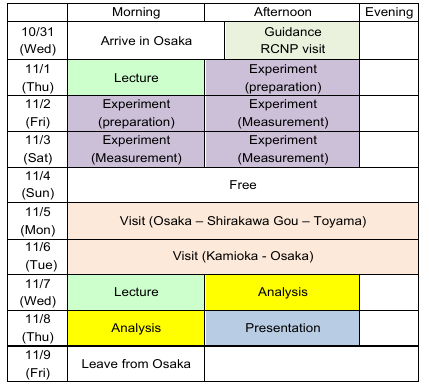
Fig. 3. Schedule in 2018 SAKURA Science plan.